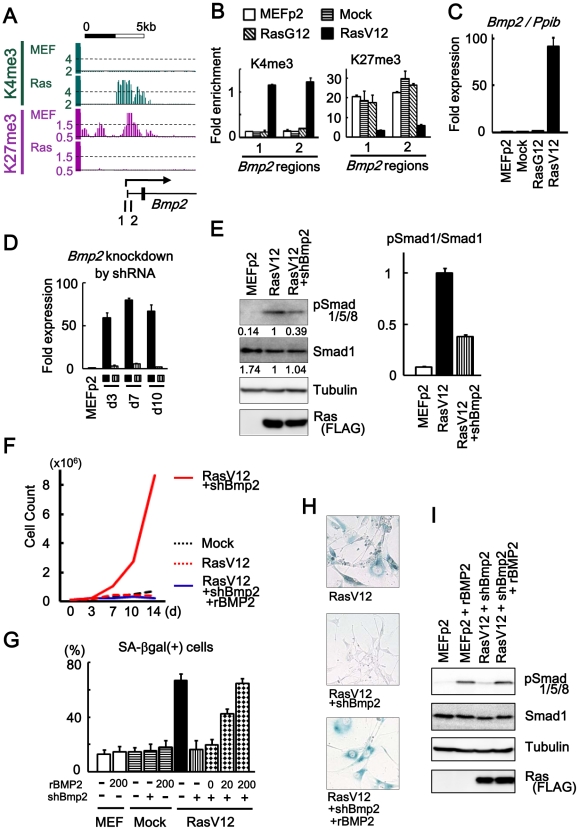

Bmp2 upregulation in senescence.(A) Maps around TSS of Bmp2 showing gain of H3K4me3 and loss of H3K27me3. 1, 2; regions for ChIP-PCR. (B) Real-time ChIP-PCR showing H3K4me3 gain and H3K27me3 loss specifically in RasV12 cells. There was no alteration in Mock cells and RasG12 cells, thus no alteration during passages. (C) Real-time RT-PCR analysis for Bmp2, showing upregulation to 92-fold specifically in RasV12 cells. There was no increase in Mock cells and RasG12 cells, thus no alteration during passages. (D) Real-time RT-PCR showing knock-down of Bmp2 to 0.05–0.08 fold by shRNA on days 3, 7, 10. Closed square, infected with RasV12 cells. Vertical-striped, infected with RasV12 and shBmp2. (E) Western blot analysis showing increased level of Smad1/5/8 phosphorylation in RasV12 cells, and decrease in Bmp2-knocked-down RasV12 cells. RasV12 with N-terminal FLAG was detected using anti-FLAG antibody. Numbers under bands of phosphorylated Smad1/5/8 and pan-Smad1 showed densities relative to the band for RasV12 cells (left panel), and the ratio of densities for phosphorylated Smad1/5/8 to pan-Smad1 was decreased to 0.38-fold in Bmp2-knocked-down RasV12 cells (right panel). (F) Growth curve. Bmp2-knocked-down RasV12 cells (red solid) showed continual growth faster than Mock cells (black dotted). Growth of Bmp2-knocked-down Mock cells (co-infection of shBmp2 and Mock retroviruses, data not shown) was similar to Mock cells. When cultured with rBMP2 (blue solid), the cells senesced like RasV12 cells (red dotted). (G) The number of SA-βgal(+) cells (%). When 0, 20, and 200 ng/mL of rBMP2 protein (R&D systems #355-BM) were added to Bmp2-knocked-down RasV12 cells in culture medium with 10% serum, the number of SA-βgal(+) cells was increased in dose-dependent manner. The number of SA-βgal(+) cells was not increased when Mock cells or MEF without infection was exposed to 200 ng/mL of rBMP2 protein. (H) SA-βgal staining. Bmp2-knocked-down RasV12 cells showed decreased number of SA-βgal(+) cells compared to RasV12 cells. When cultured with rBMP2 protein, the number of SA-βgal(+) cells was increased (representative result at 200 ng/mL rBMP2). (I) Western blot analysis showing increased level of Smad1/5/8 phosphorylation when exposed to 200 ng/mL of rBMP2.